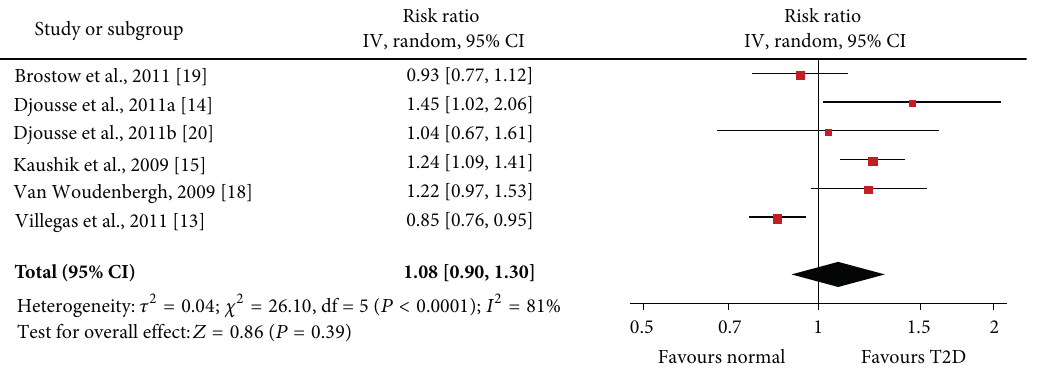
Figure 6: Forest plot of the meta-analysis for LC n-3 PUFA intake and incidence of type 2